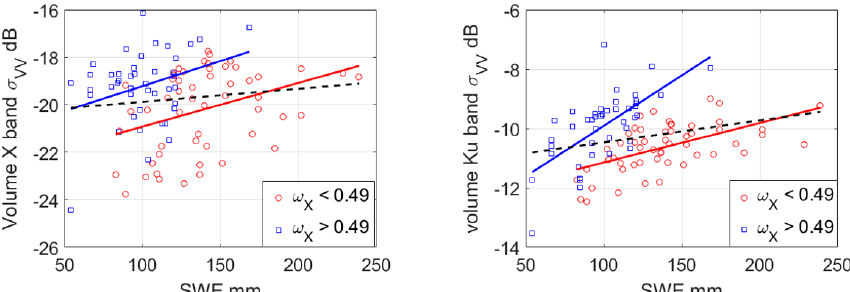
Figure 14. Volume scattering of the Canada SnowSAR data as a function of SWE based on the retrieved scattering albedo ω X at (a) X-band and (b) Ku-band. Radar observations are from a single flight. A priori estimates are used to classify ω X into two classes. They are plotted by different-colored markers. The dashed black curve is the regression line of all Canada SnowSAR data. The solid blue and red curves are the regression lines for backscatter with ω X larger and smaller than 0.49, respectively. Figure from Zhu et al. (2018).